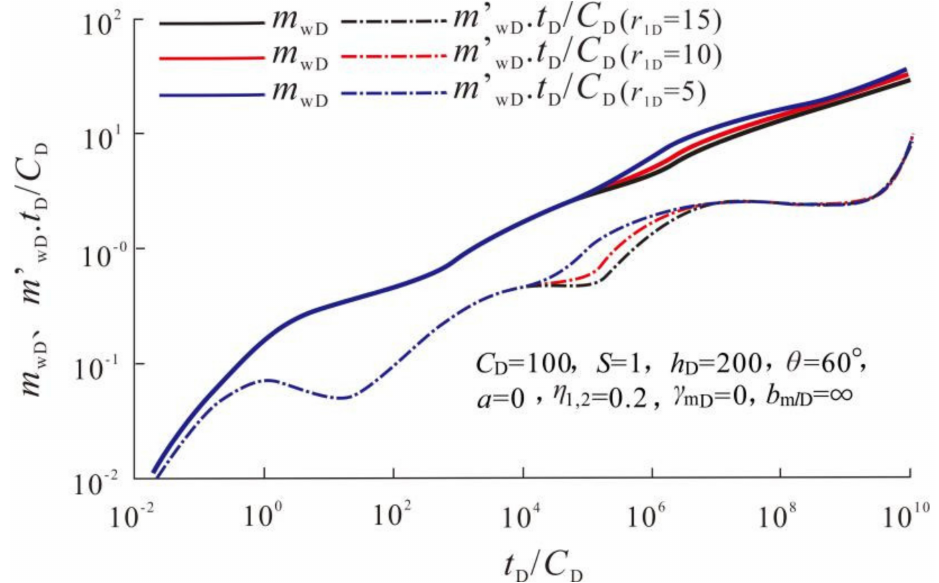
Figure 6. Effect of the internal radius on dynamic pseudo pressure curves.